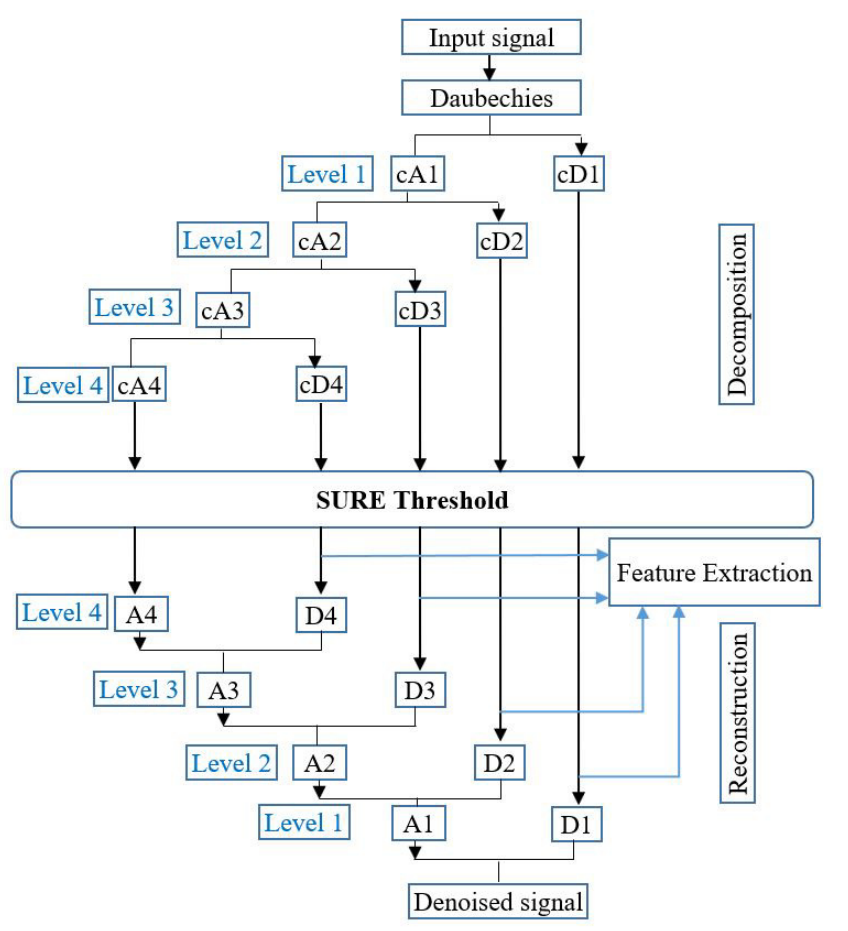
Figure 3. Process of wavelet analysis.